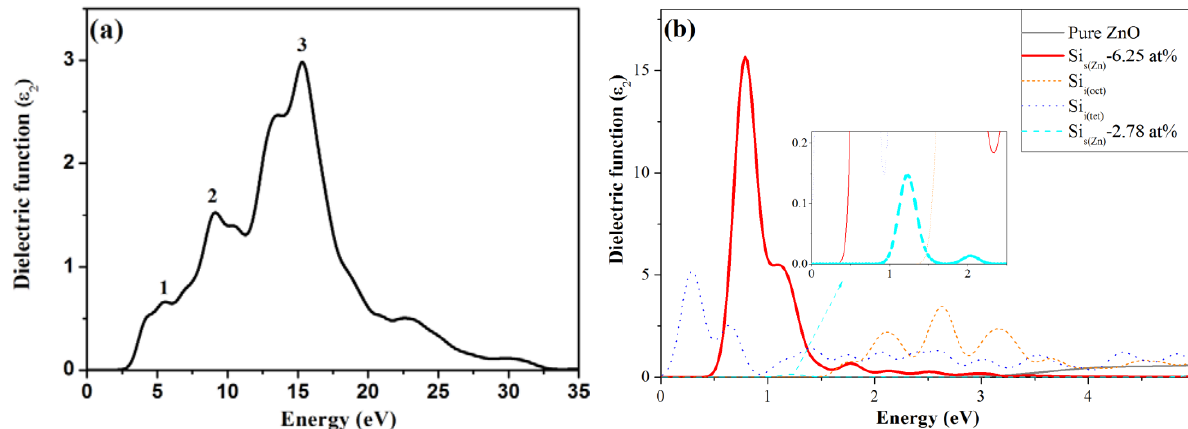
Figure 7. Imaginary part of the dielectric function of ( a ) pure ZnO; ( b ) Si-doped ZnO.